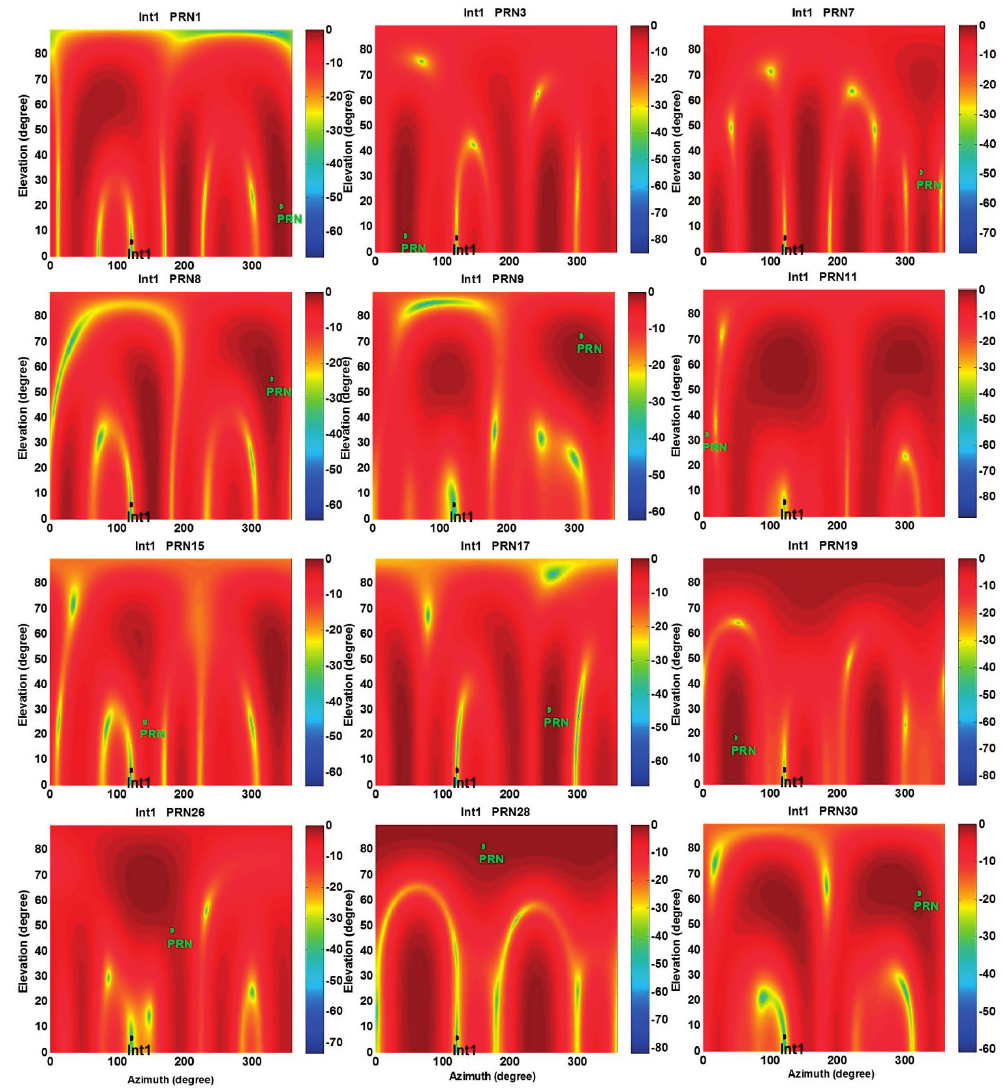
Figure 6. Normalized antenna array gain patterns at the interference frequency for the proposed distortionless STP filtering.